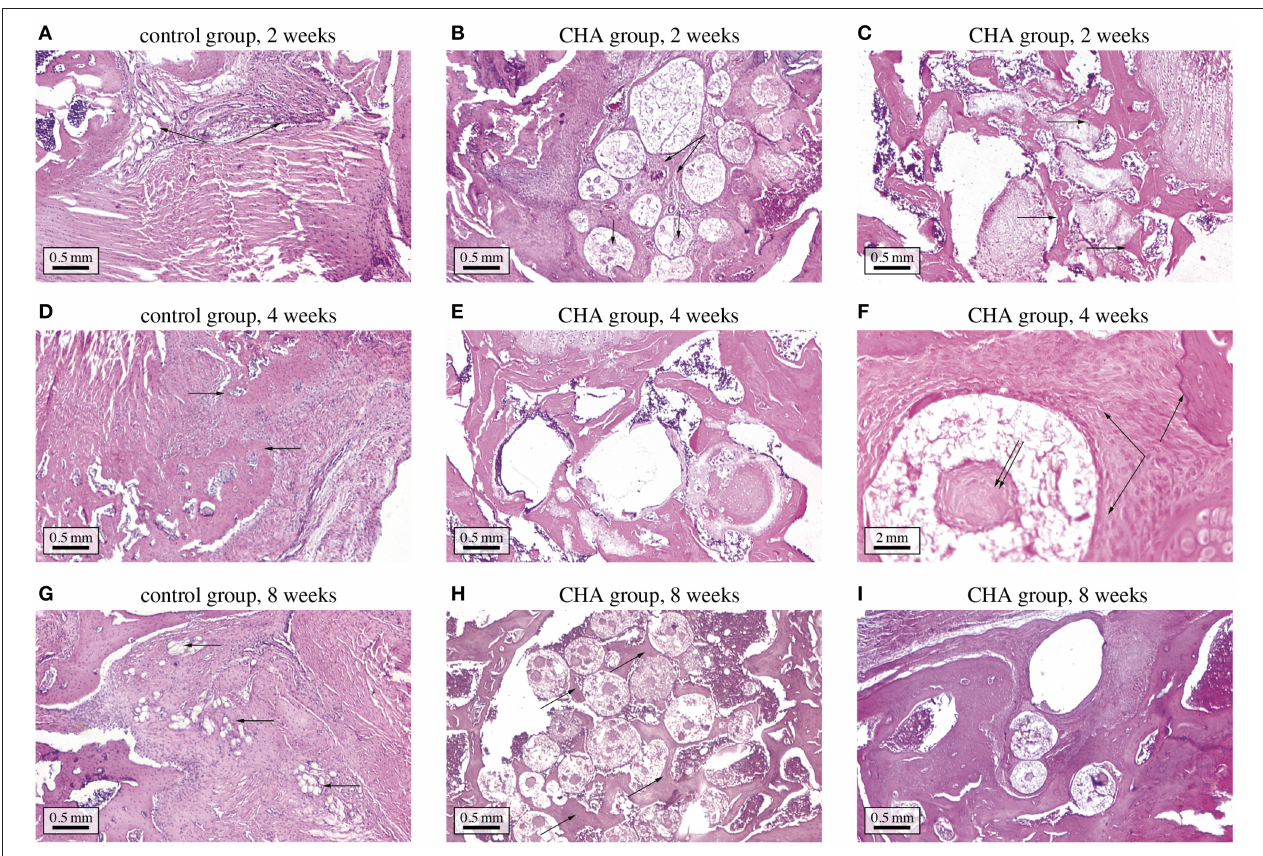
FIGURE 3 | Histological study of bone regeneration in bone defects optionally containing CHA granules. (A) control group at 2 weeks after implantation—the bone defect is filled with connective tissue; (B) CHA group at 2 weeks after implantation—the granules are surrounded with connective tissue, in some granules osteoid formation can be discerned ; (C) CHA group at 2 weeks after implantation—near bone edges granules are surrounded with woven bone; (D) control group at 4 weeks after implantation—the bone defect is filled with connective tissue and woven bone; (E) CHA group at 4 weeks after implantation—the granules in the center of the defect are mostly surrounded with trabecular and woven bone; (F) CHA group at 4 weeks after implantation (higher magnification)—woven bone is forming around and inside CHA granule; (G) control group at 8 weeks after implantation—newly formed bone can be discerned at the edges of the bone defect; (H) CHA group at 8 weeks after implantation—trabecular bone has formed between CHA granules; (I) CHA group at 8 weeks after implantation—near bone edges granules are integrated in well-formed trabecular